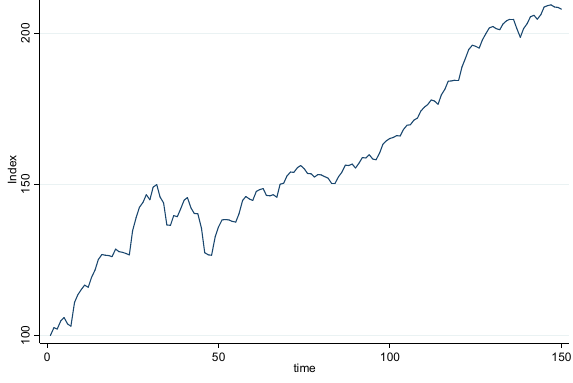
Figure 1. Stockholm housing market. Note: The apartment price index. The Stockholm housing market and segments of the market (the x ‐axis is the measuring price index and the y ‐axis is the measuring time).